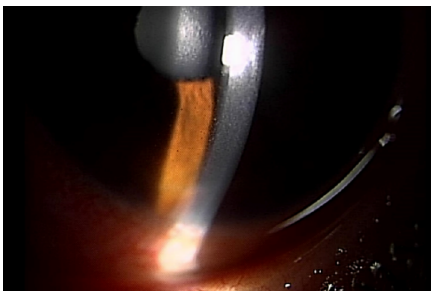
Figure 2: Keratic precipitates and cells in the anterior